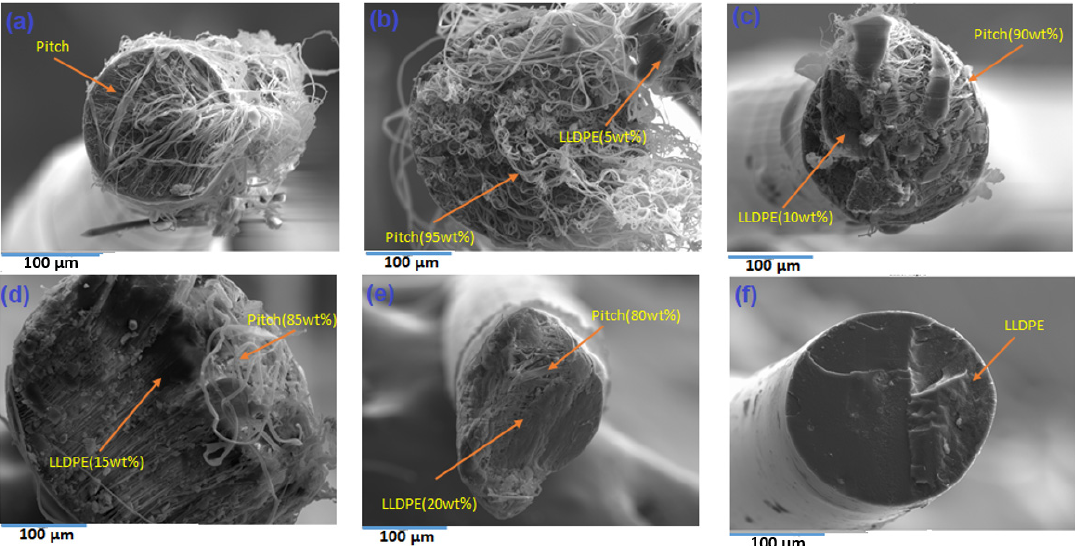
Figure 4. Morphology of fibres with LLDPE content in LLDPE/mesophase pitch blend. ( a ) Pure mesophase pitch, ( b ) 5 wt% LLDPE/mesophase, ( c ) 10 wt% LLDPE/mesophase pitch, ( d ) 15 wt% LLDPE/mesophase pitch, ( e ) 20 wt% LLDPE/mesophase pitch and ( f ) 100% LLDPE.